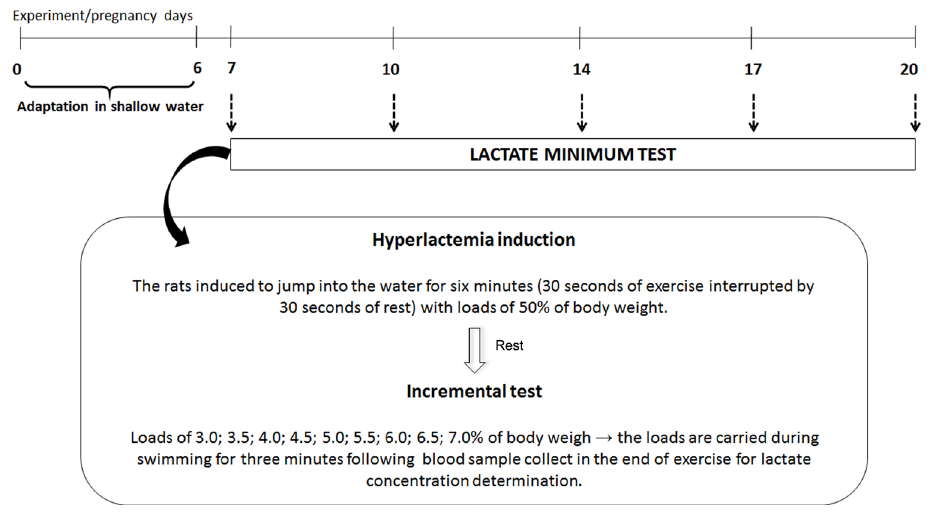
Figure 1 - Experimental design of LacMin test performed in pregnant and non-pregnant rats for swimming protocol.